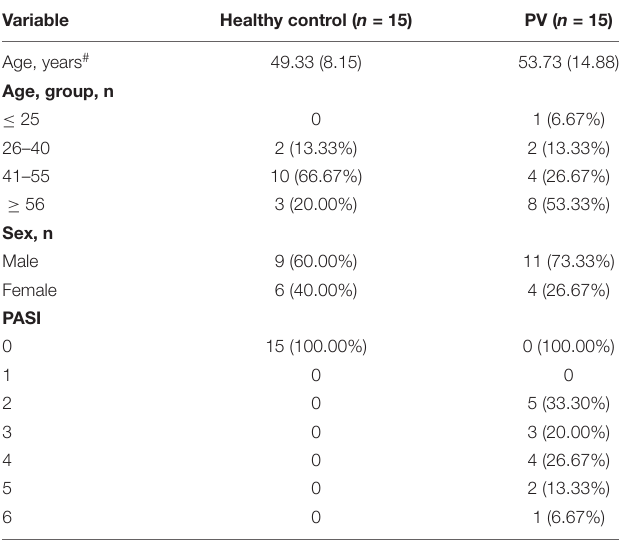
# Age data are presented as the mean (SD). PV: psoriasis vulgaris; HC: healthy controls.